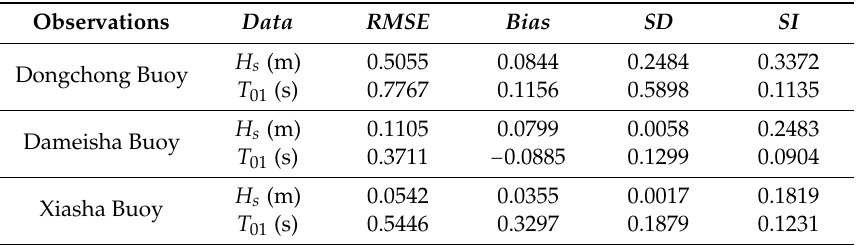
Table 7. Summary of the statistical errors for the simulations during Typhoon Kalmaegi process from 12 to 18 September 2014.